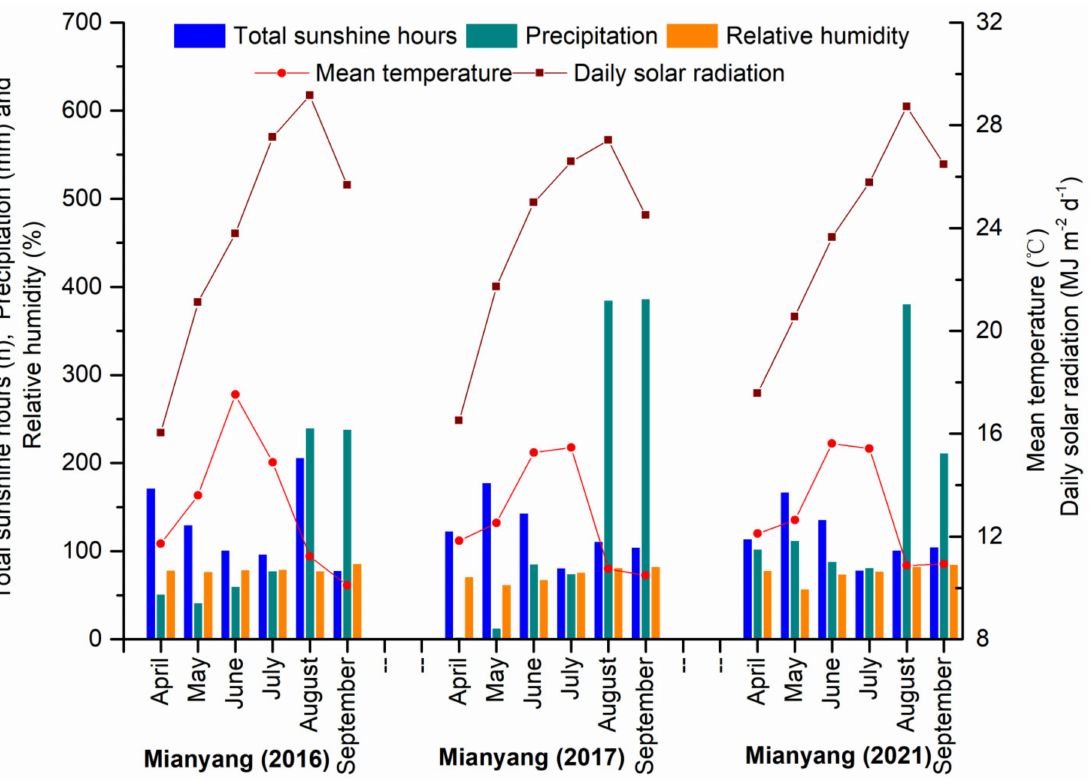
Figure 1. Precipitation, total sunshine hours, relative humidity, mean temperature, and daily solar radiation across the growing seasons of rice in Mianyang. Precipitation and total sunshine hours are mon3LHy totals. Temperatures, daily solar radiation, and relative humidity are the mon3LHy averages.